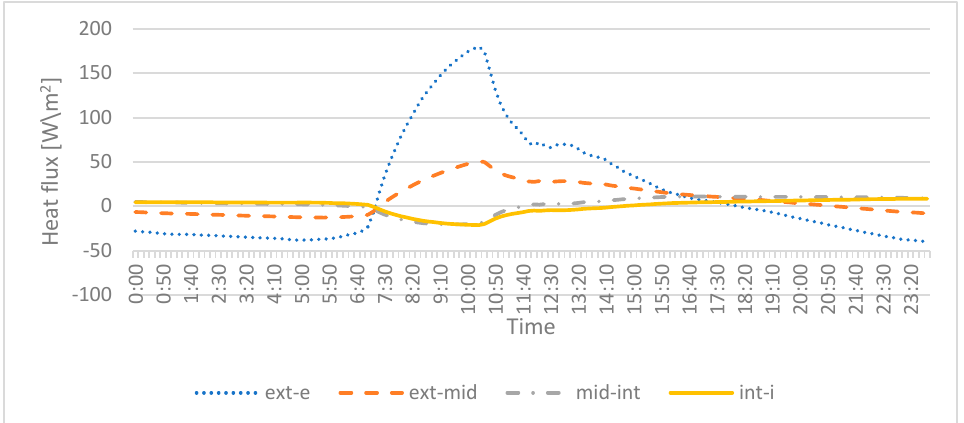
measurements of a single brick. Heat fluxes were analysed for 27 June 2021 and for an exemplary summer day and 8 January 2021 for a winter day. The chart for 27 June is shown in Figure 14.